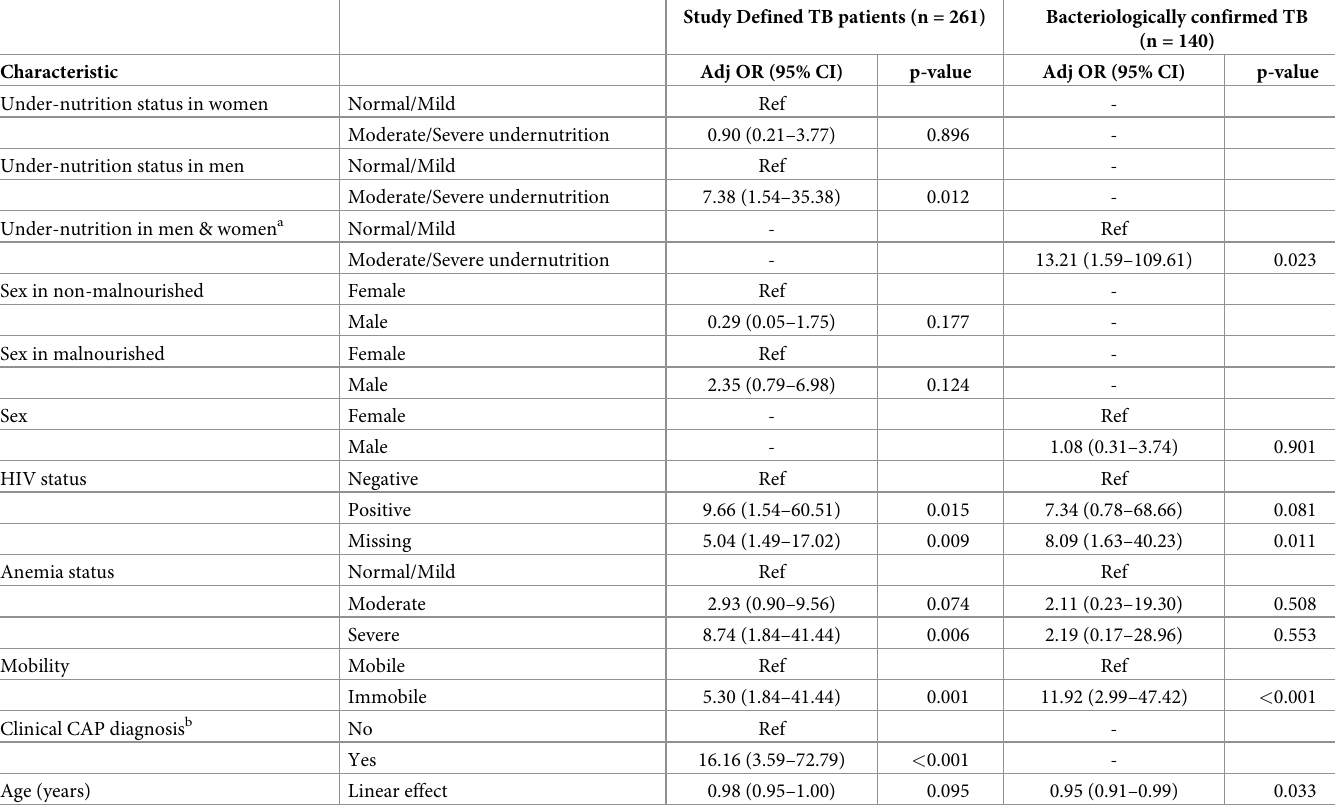
Table 4. Multivariable analysis of risk of mortality (D3-D28) in Study-defined TB cases (N = 261) [excluding 3 EXPTB] and Bacteriologically confirmed (N = 140).